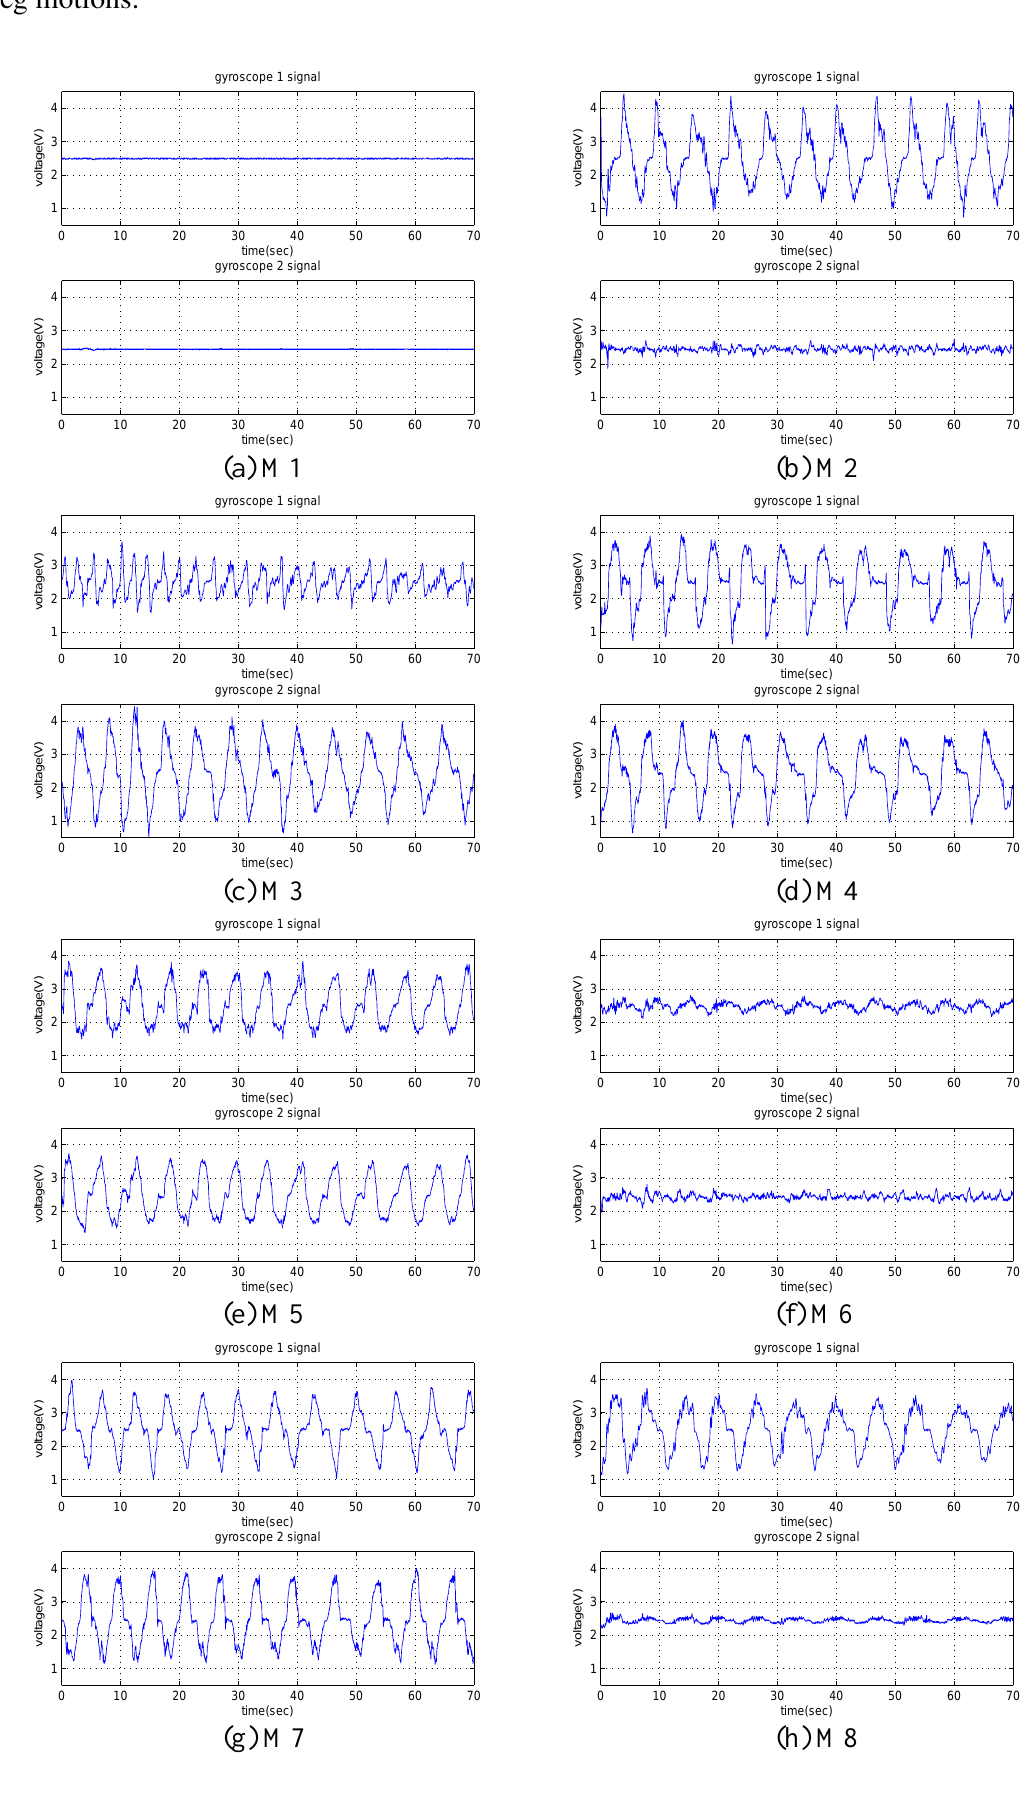
Figure 5. Signals of the two gyroscopes (gyro 1 and gyro 2) for the eight different leg